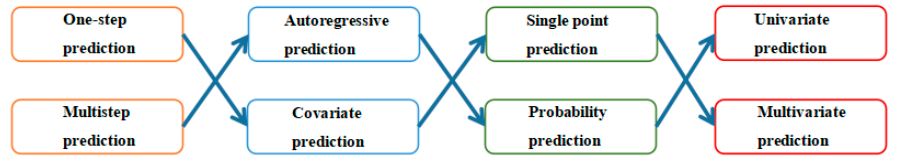
Figure 2. Time-series prediction classification.